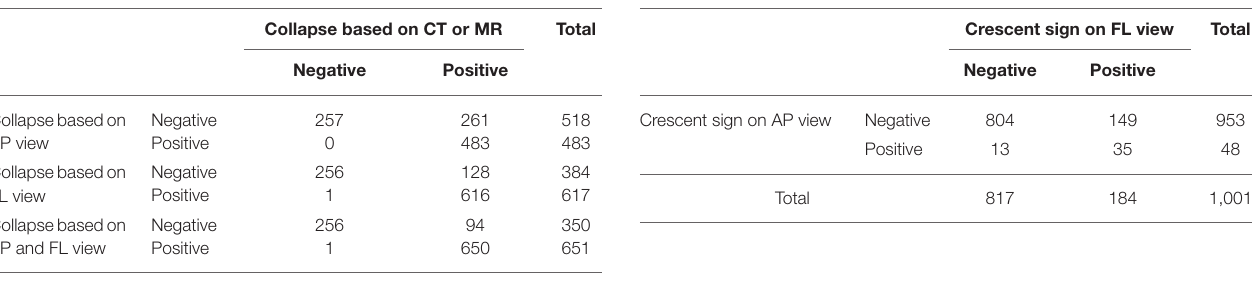
TABLE 2 | Comparation between standard radiograph and golden standard. TABLE 3 | Comparation of crescent sign between AP and FL